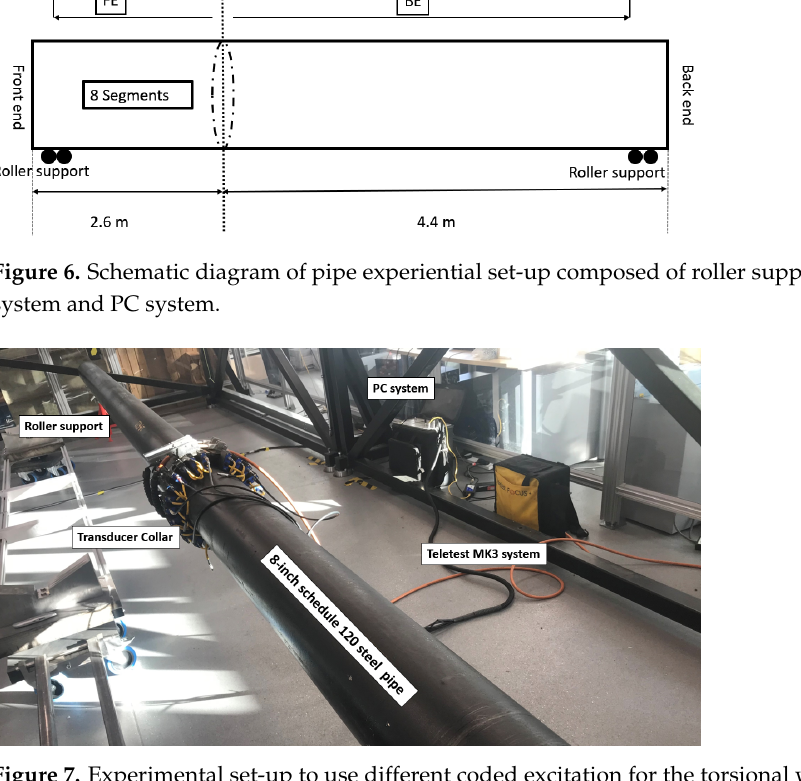
Figure 7. Experimental set-up to use different coded excitation for the torsional wave mode T(0,1) generation. Table 1. The excitation sequences